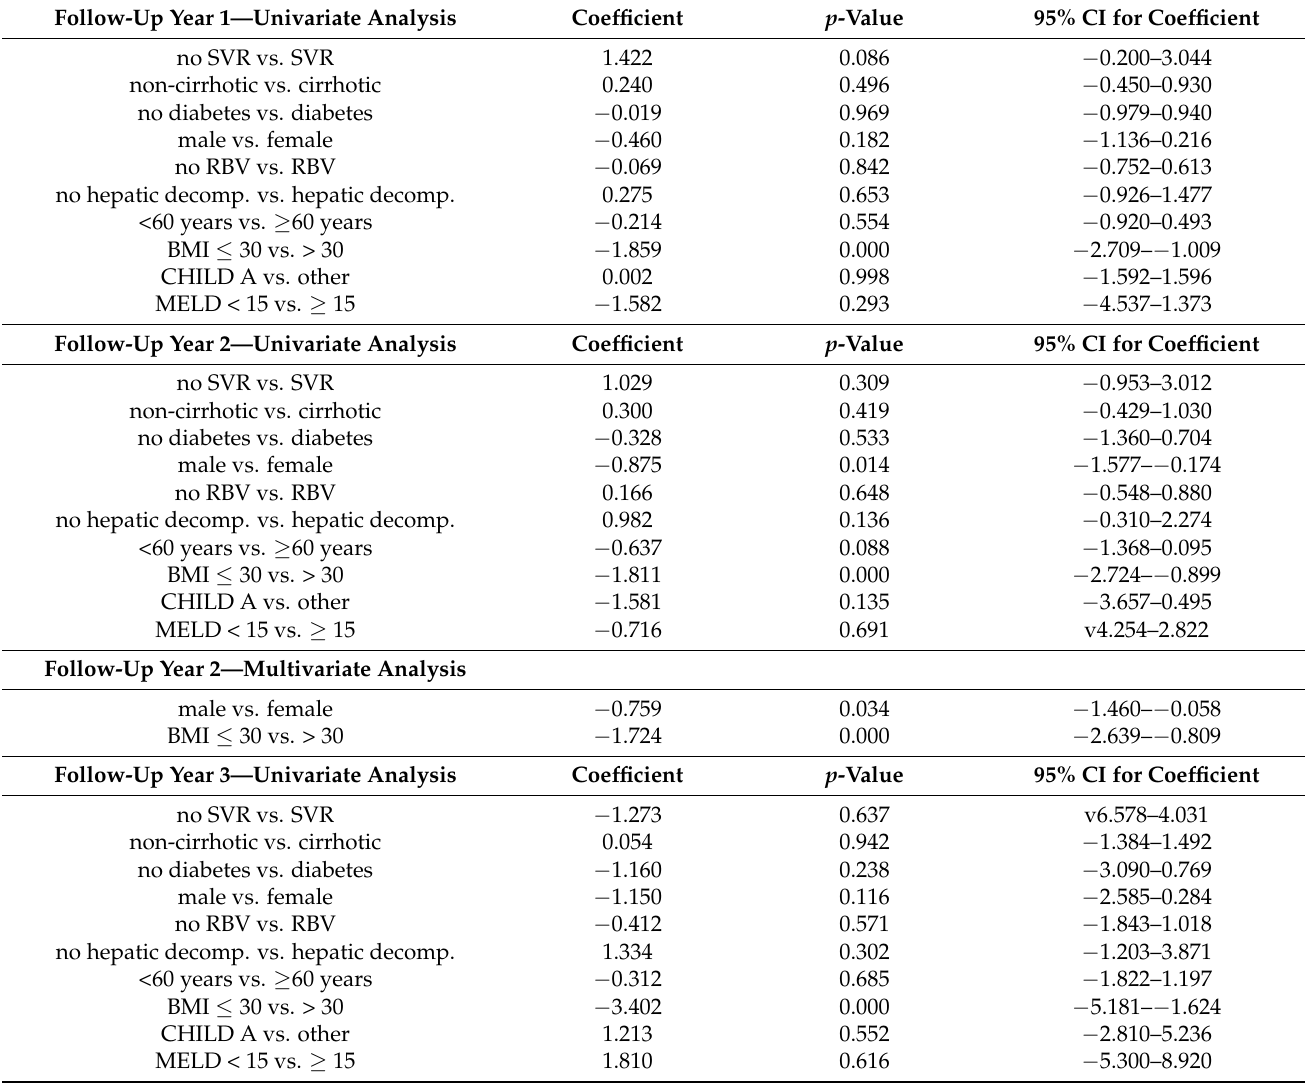
Table 2. Univariate und multivariate regression analysis for predictors of weight gain in the course of DAA treatment at FU1, FU2, and